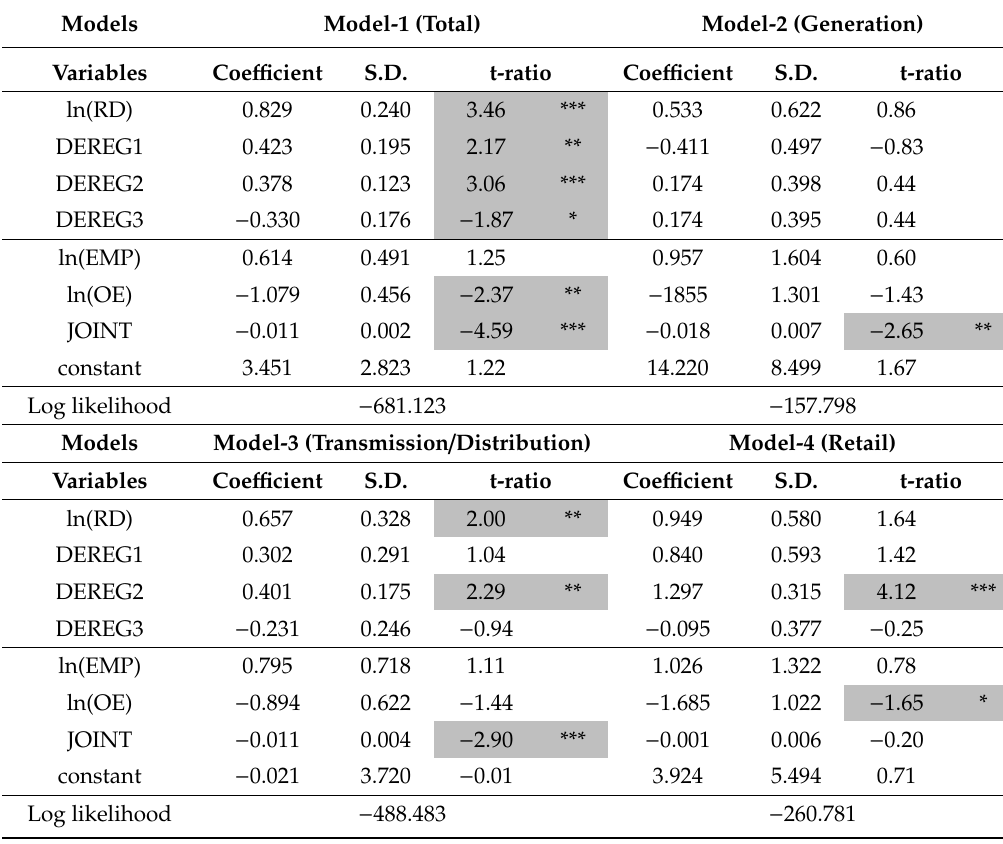
Table 3. Estimation